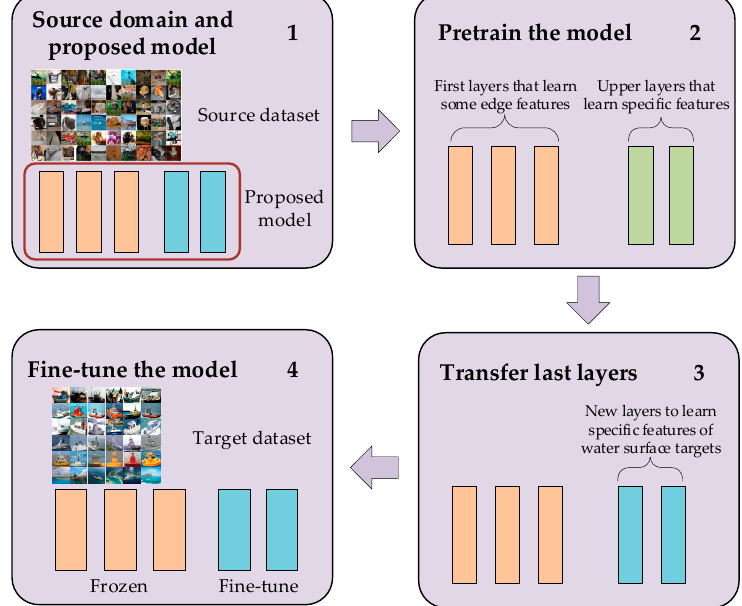
Figure 6. Steps of transfer learning. First, suitable source dataset should be found. Then, the model is pretrained on the source domain. Eventually, parameters are transferred and fine-tuned on our self-built dataset.